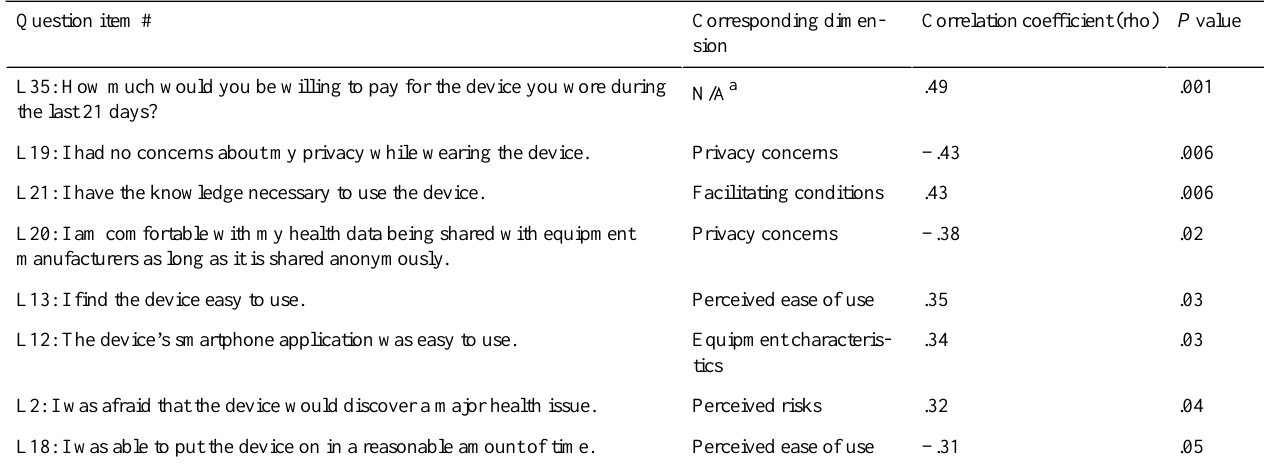
Table 6. Correlation between technology acceptance questionnaire and technology